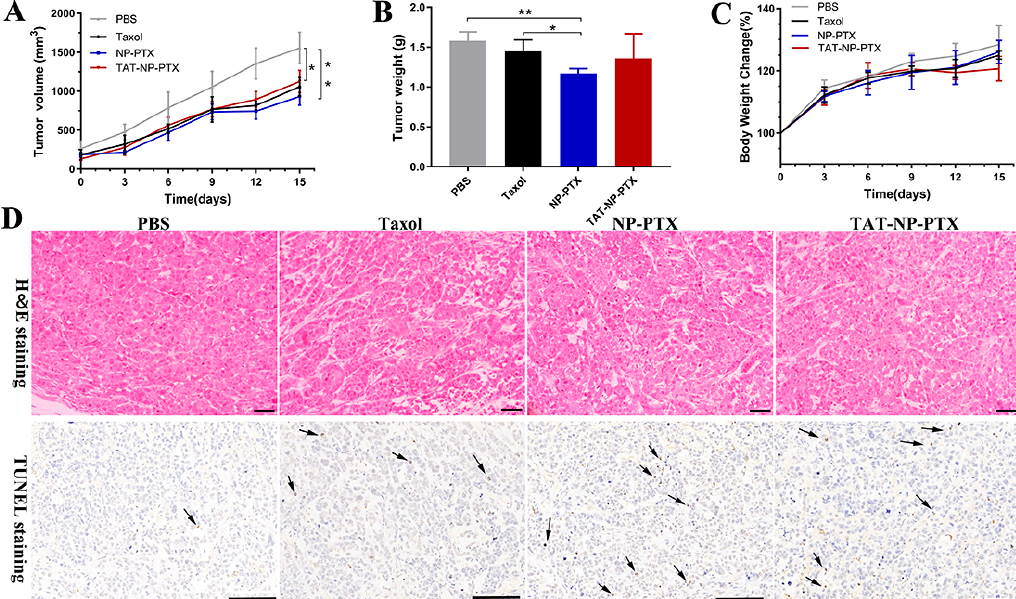
Figure 5. In-vivo antitumor effect at a dosage of 10 mg/mL PTX. ( A ) Tumor volume change curves throughout the treatment. ( B ) Average weight of tumors at the end of treatment after dissection. ( C ) Body weight change curves throughout the treatment. ( D ) Hematoxylin-eosin (H&E) and terminal deoxynucleotidyl transferase nick end labeling (TUNEL) staining of the tumor sections. Data are expressed as the mean ± SD ( n = 6, * p < 0.05, ** p < 0.01,). Bar = 100 μ m.